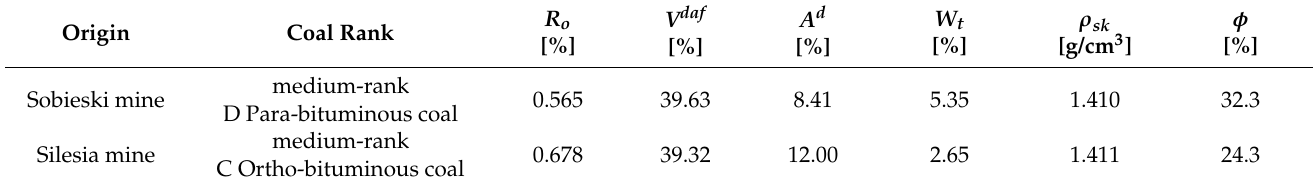
Table 1. Technical and petrographic parameters of the studied coal